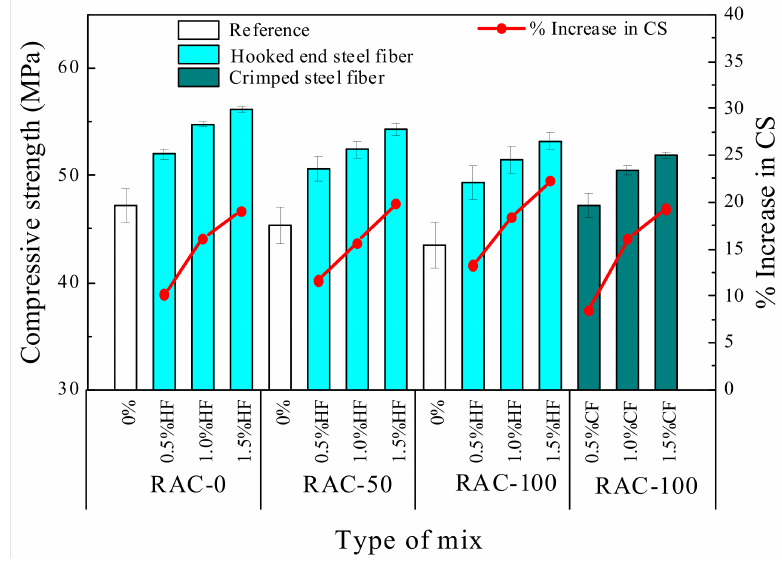
Figure 5. Compressive strength of fiber-reinforced RAC specimens.